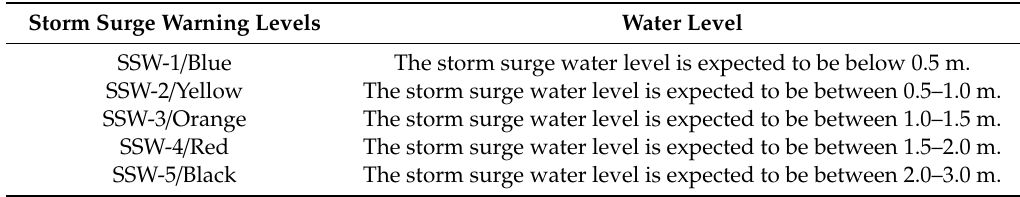
Table 1. Surge warning levels (SSW) in Macau.